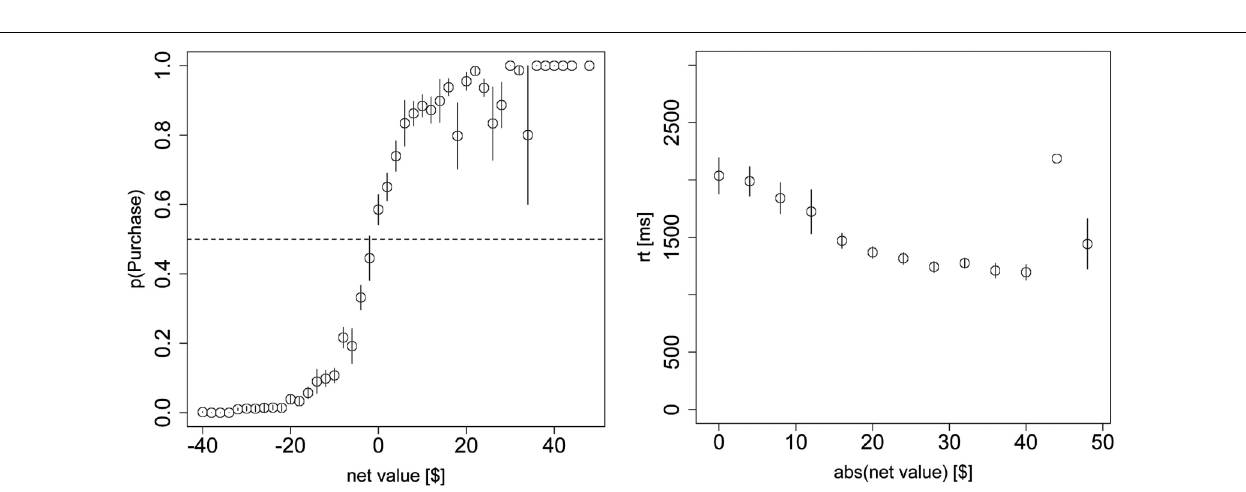
FIGUREA3 | Replication of Figures2A,B choice and reaction time curves but using all of the data, including the $0 bids and net values beyond + / − $20.